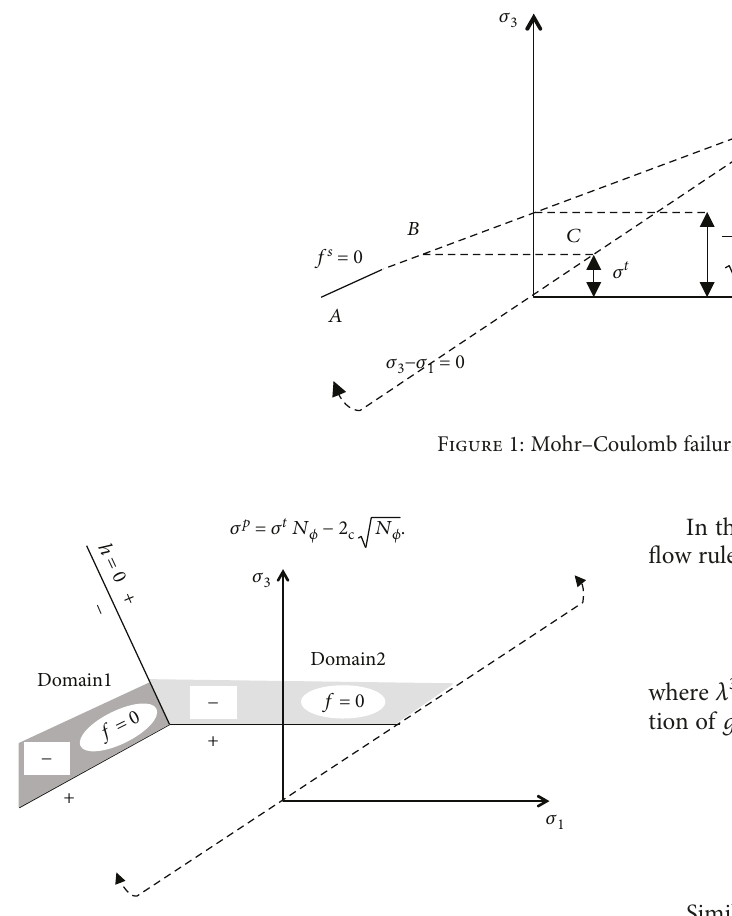
Figure 2: Plastic fl ow rule in the Mohr – Coulomb